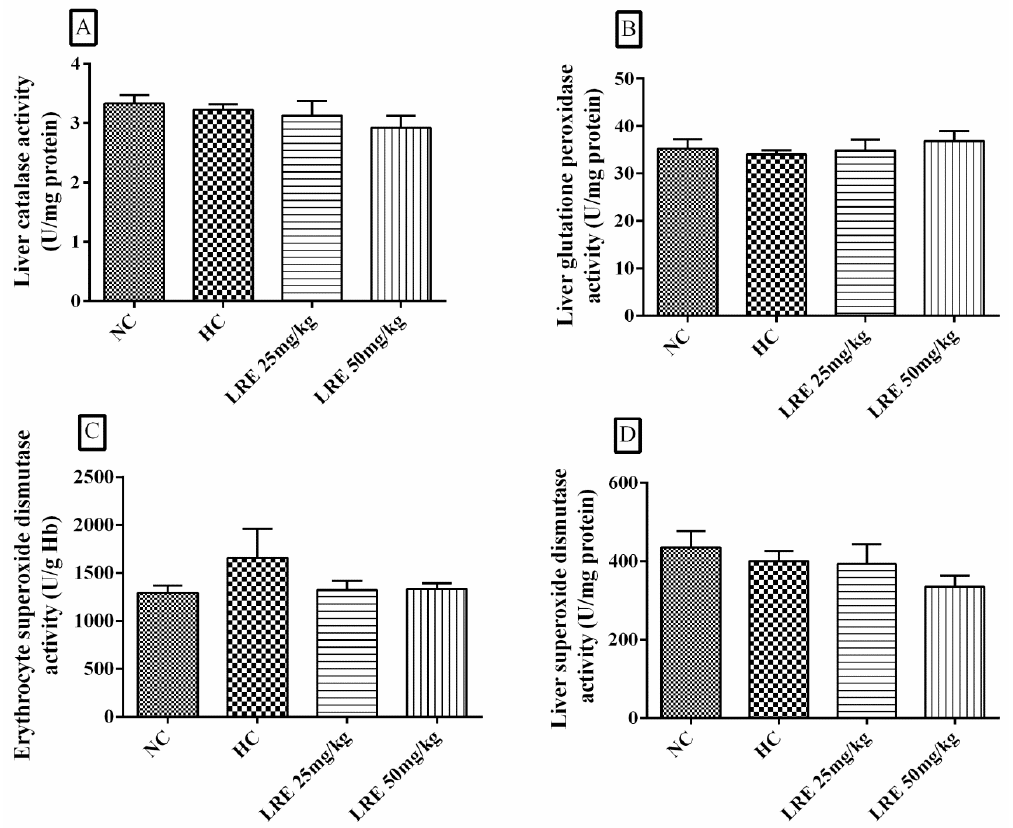
Figure 7. Activity of catalase (CAT), glutathione peroxidase (Gpx), erythrocytic superoxide dismutase (SOD-e) and superoxide dismutase (SOD-h) of hamsters submitted to experimentally induced dyslipidemia and treated with LRE. Each column represents mean ± SEM (standard error of the mean) of 7-9 animals/group.